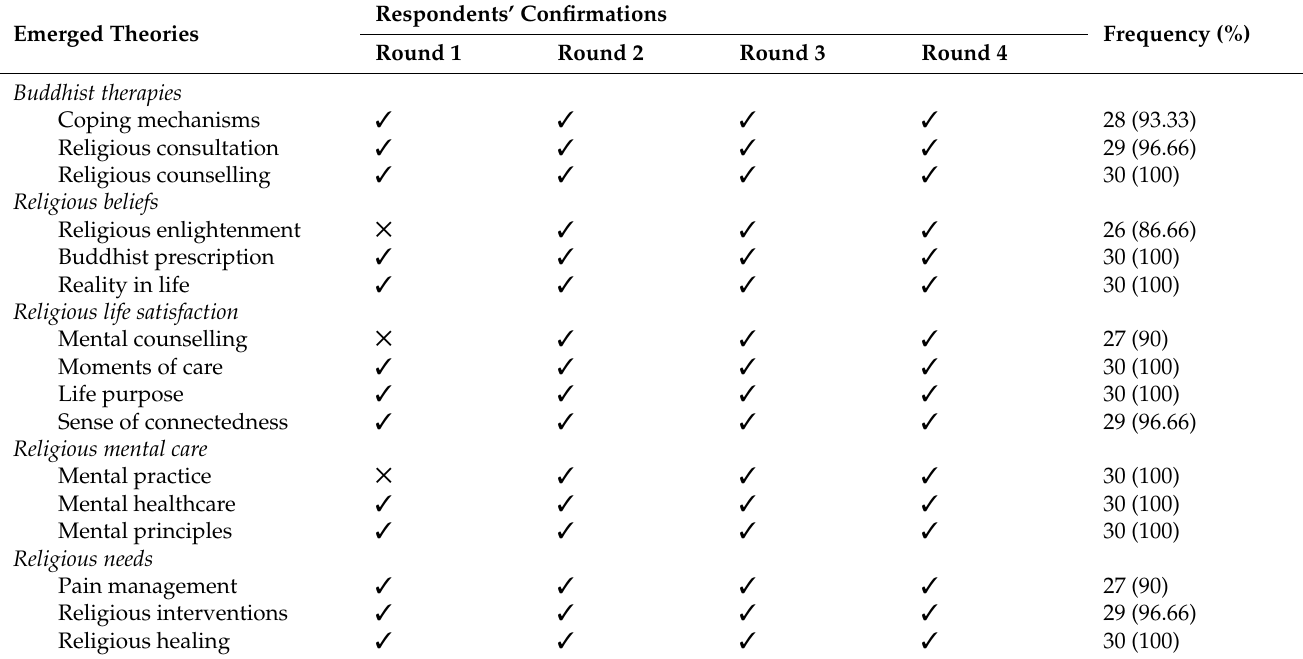
Table 4. The final themes’ emerged